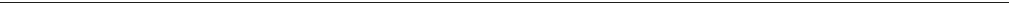
Fig. 6 We identify discrete putative clusters using an iterative binary clustering approach on 645 cells. The top six panels show the summary of clusters obtained by iterative binary clustering using electrophysiological features extracted from the traces and GLIF model parameters. In every panel, each row represents a cluster, and each column a transgenic line. The size of the circle indicates the fraction of cells from a given transgenic line falling into a speci fi c cluster (such that the sum of fractions in a column add up to 1). The dendrogram on the y -axis shows the iterative binary splitting into clusters using the algorithm explained in the text. For each intermediate node, a support vector machine was trained on half the cells at that node and used to classify the remaining cells. The number at each node indicates the minimum percentage of test cells correctly classi fi ed over 100 iterations of randomly selected training and test cells. Clustering based on features and using the GLIF 3 and GLIF 4 model parameters shows separation among lines labeling inhibitory and excitatory cells. In addition, transgenic Cre lines marking Pvalb+, Ntsr1+, Nr5a1+, and Ctgf+cells tend to segregate into distinct clusters. The bottom two panels show two measures of overall clustering similarity: the adjusted Rand index (ARI) in red, and the adjusted variation of information (AVOI) in black. The bottom left panel shows similarity between each set of clusters and the transgenic lines. The bottom right panel shows similarity between each set of clusters and the clusters obtained using the features. An ARI of 1 indicates perfect agreement between partitions, whereas 0 or negative values indicate chance levels of agreement. A positive value of the AVOI indicates agreement between partitions that is better than chance (which is indicated by 0). The gray and pink traces in these two panels show the AVOI and ARI values, respectively, for random subsets of the features containing the same number of parameters as each of the four GLIF